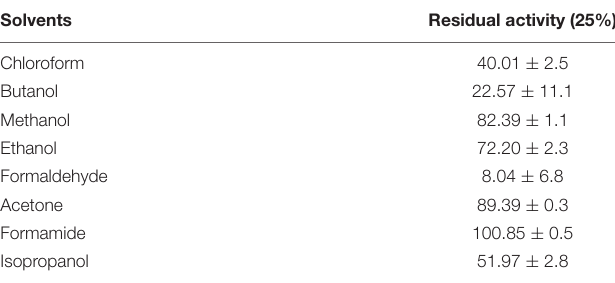
TABLE 4 | Effect of organic solvents on activity of PyCP.